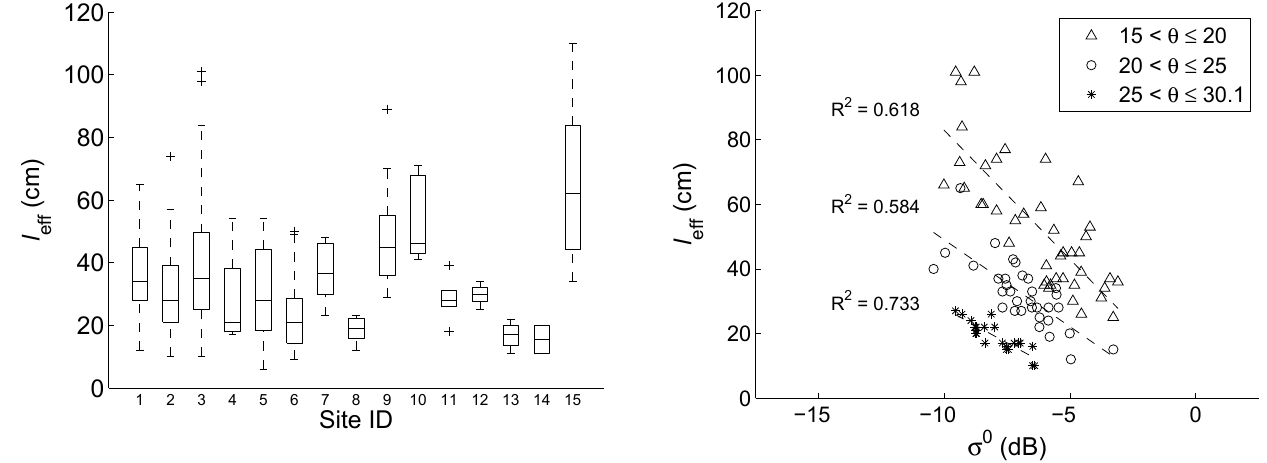
Fig. 8. Dependence of s e(cid:11) on the normalised backscatter observations ( (cid:27) 0 angle (cid:18) .